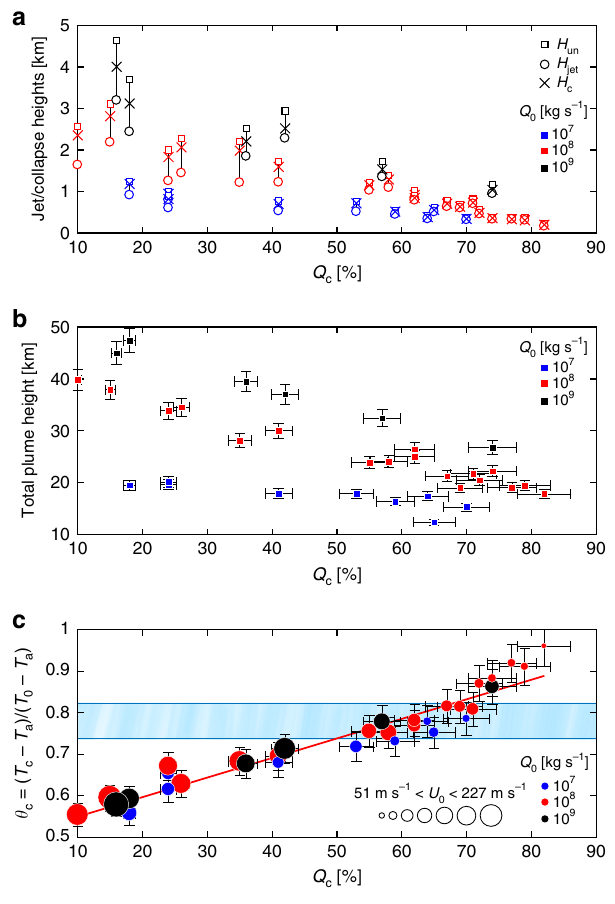
Fig. 3 Summary of the numerical results. a Characteristic heights of the eruption jet as a function of the percentage of collapse Q c for all the simulated dynamics. Square symbols show the height at which the mean upward momentum of the central uneroded axis is exhausted ( H un ). Circle symbols indicate the height at which the mean upward momentum of the whole eruptive column is exhausted ( H jet ). Cross symbols represent the critical height at which the eruptive column starts to collapse ( H c ; see Methods section). b Variation of the maximum plume height as a function of Q c . c Relationship between Q c and its corresponding average temperature value T c normalized to the initial magmatic temperature T 0 with respect to the atmospheric air temperature T a ( θ c ). Blue, red, and black symbols in a – c represent the adopted mass eruption rate Q 0 at the source, and their size in c represents the relative exit velocity U 0 . The upper and lower bounds of the light blue horizontal bar in c result from the ratio between the glass transition temperatures T g for rhyolitic and trachytic magmas, and their common eruptive temperature ranges. T g is taken anhydrous consistent with the initial condition of numerical experiments that involve the total volatile exsolution at vent. The red solid line shows the linear least square regression ( r 2 = 0.92; p value = 1.50 × 10 − 18 ). A 10% of error is applied in panels b and c due to the mesh geometry (panel a is excluded for fi gure readability), as suggested by ref. 23 . Full references to the data sets used in the graph are reported in the Supplementary Table